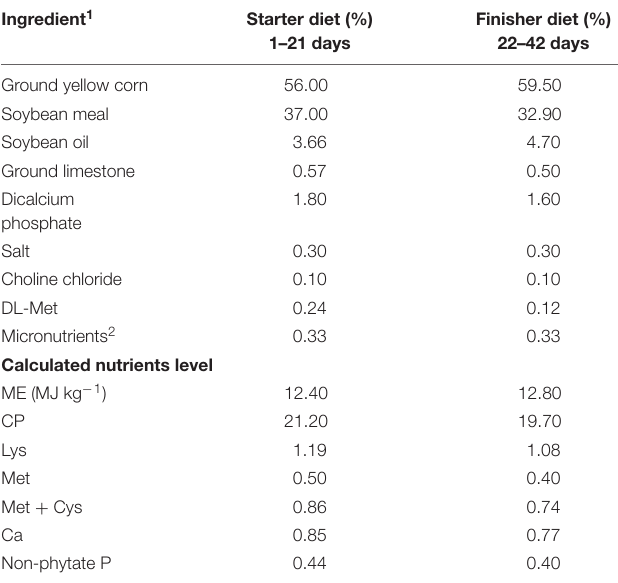
TABLE 1 | Composition of basal diets for broiler chickens.